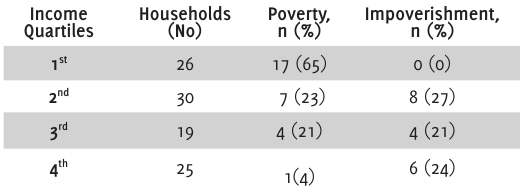
Table 5. Poverty and Impoverishment across Income Quartiles (n =